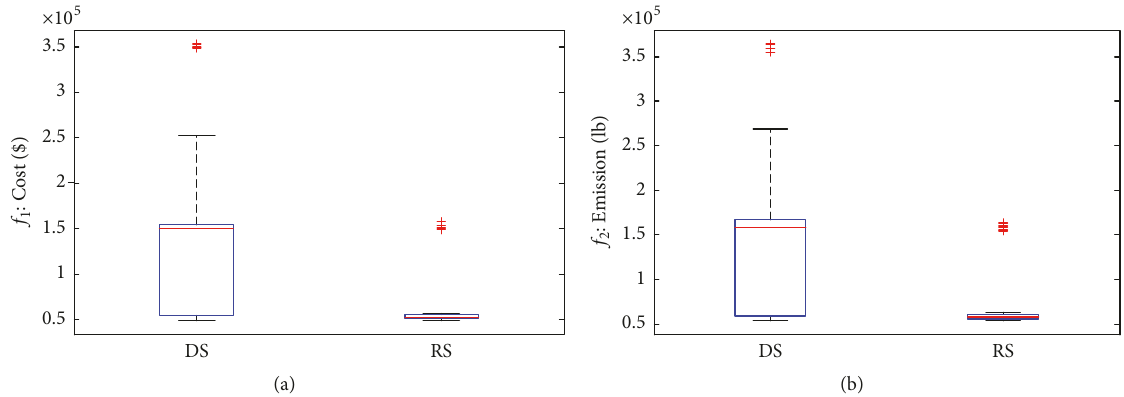
Figure 6: Boxplot for results of deterministic solutions (DS) and robust solutions (RS): (a) 𝑓 1 (cost); (b) 𝑓 2 (emission).